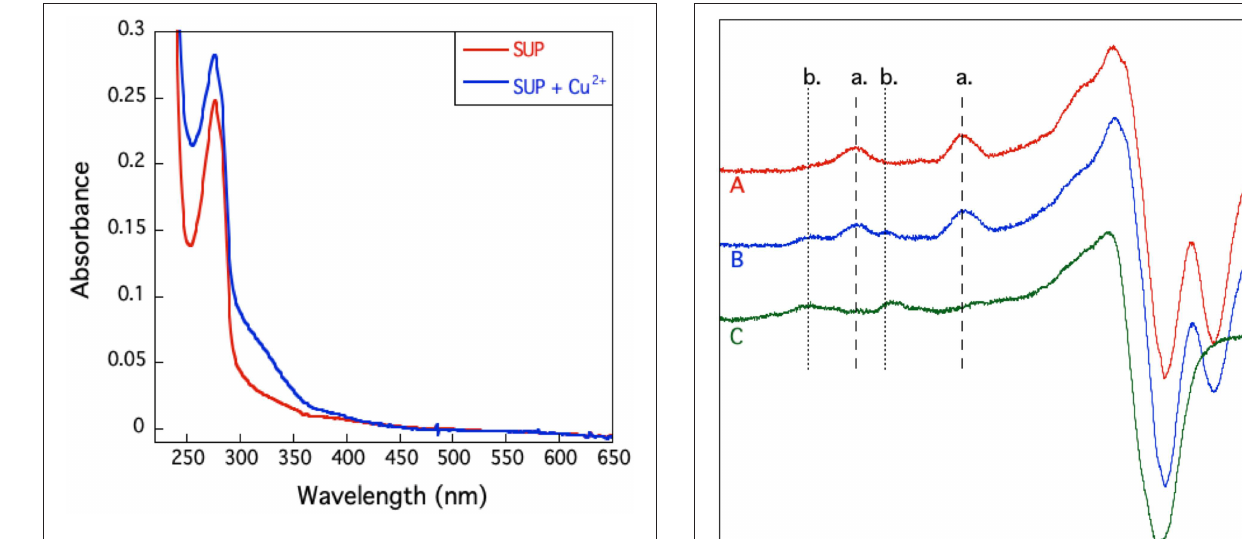
FIGURE 6 | U.V.-visible spectrum of SUP in presence and absence of Cu 2 + . The absence of an absorption band around 600nm excludes the presence of a type I copper site.